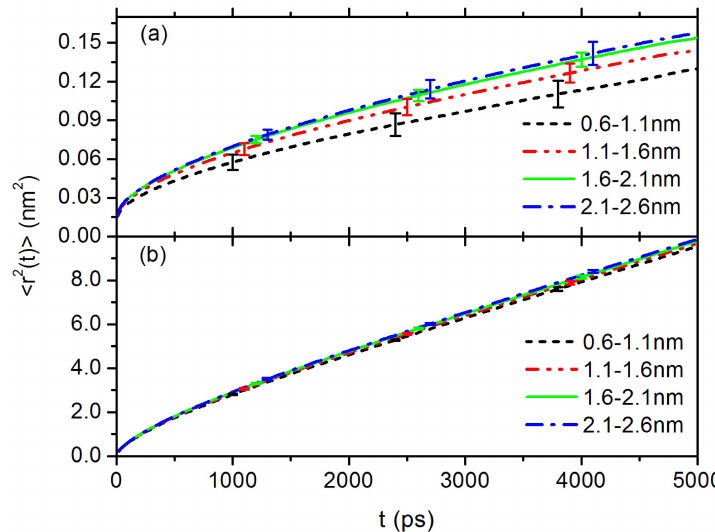
Figure 4. Layer resolved MSD of monomers in the case of: ( a ) PS around C 60 NP; and ( b ) PP around C 60